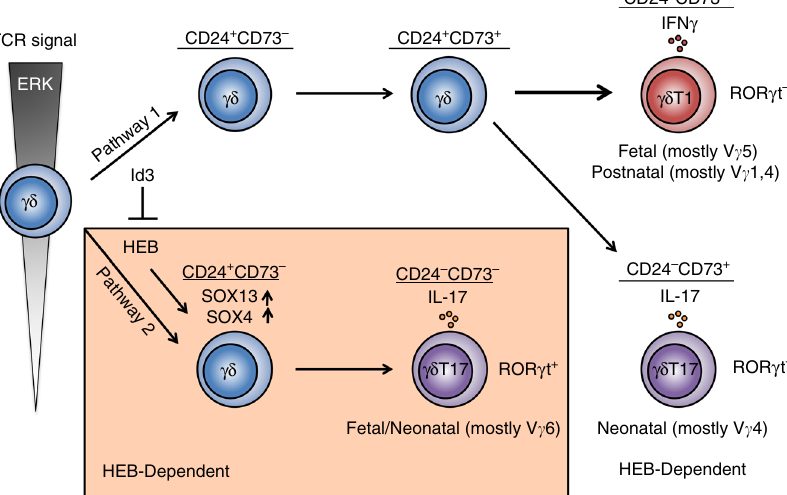
Fig. 9 Model for two HEB-dependent pathways of γδ T17 cell development. Uncommitted γδ T-cell precursors (circle on the left) encounter TCR signals that induce them to enter Pathway 1 (unboxed) or Pathway 2 (orange box), depending on the strength of ERK activity downstream of the TCR signal. Pathway 1 involves upregulation of CD73, and is favored by Id3 activity. Pathway 2 proceeds without CD73 upregulation, and entry into this pathway is dependent on HEB activity. High ERK signalling leads to the upregulation of Id3, which suppresses HEB function and thereby inhibits Pathway 2. Most cells in Pathway 1 become IFN γ -producing γδ T1 cells. In the fetal thymus, these are mostly V γ 5 + cells, whereas they are mostly V γ 4 + and V γ 1 + cells in the postnatal thymus. A minority of Pathway 1 CD24 + CD73 + cells become CD73 + γδ T17 cells that are ROR γ t + and express mostly V γ 4. HEB-de fi cient cells can take this pathway, but the resulting CD73 + ROR γ t + cells are severely defective in IL-17 production. Pathway 1 generation of γδ T17 cells is mostly restricted to the neonatal period. Pathway 2 leads to the generation of CD73 − ROR γ t + γδ T17 cells that mostly express V γ 6, and this pathway is restricted to fetal and early neonatal life. Pathway 1 generation of γδ T1 cells appears to be independent of HEB. Circles indicate cells at distinct developmental stages, arrows